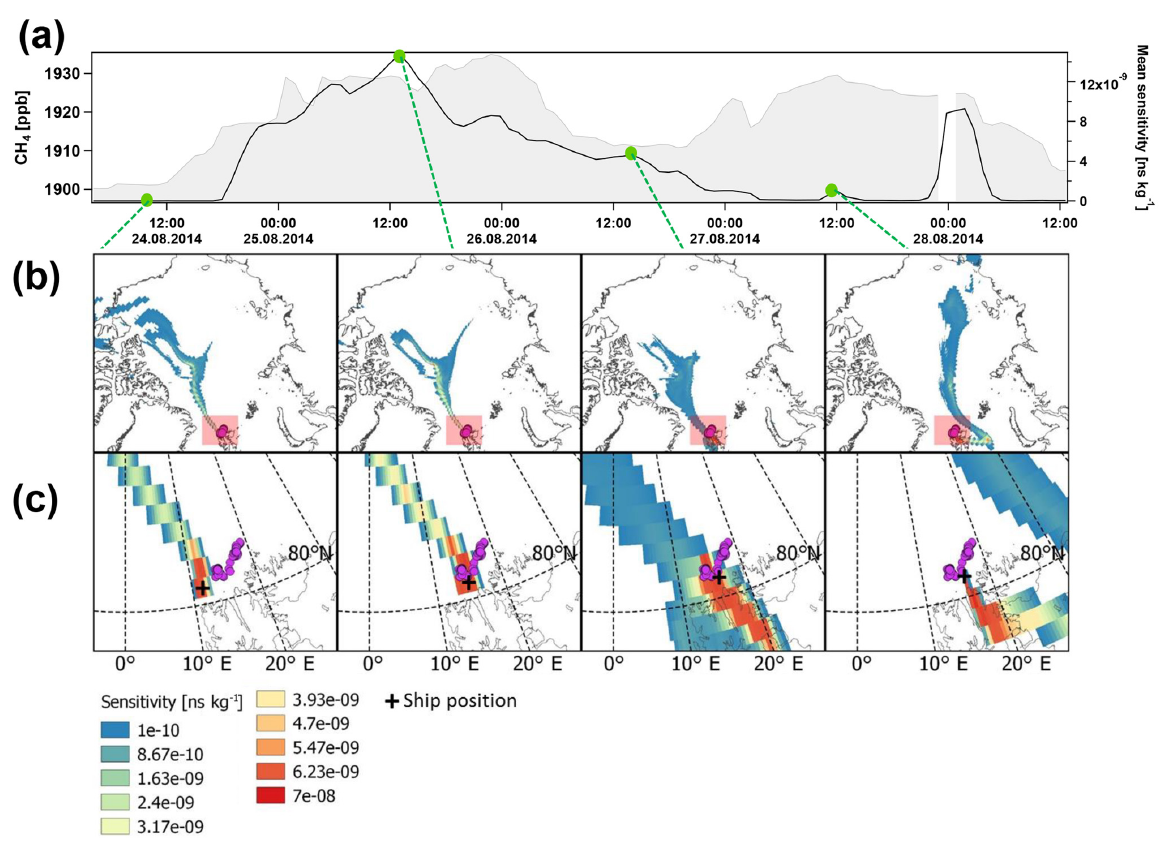
Figure 8. (a) Methane (CH 4 ) measured north of Svalbard at the RV Helmer Hanssen shortly before, during, and after an episode of increased mixing ratios (grey shaded area) and mean footprint sensitivity (black line) to active flares located at 80.39–81.11 ◦ N, 13.83–19 ◦ E, accord- ing to Geissler et al. (2016), (b) regional FLEXPART footprint sensitivities in nskg − 1 , colour scale, and (c) local footprint FLEXPART sensitivities, for the area given by the red overview in (b) , including the locations of seabed gas flares, from Geissler et al.